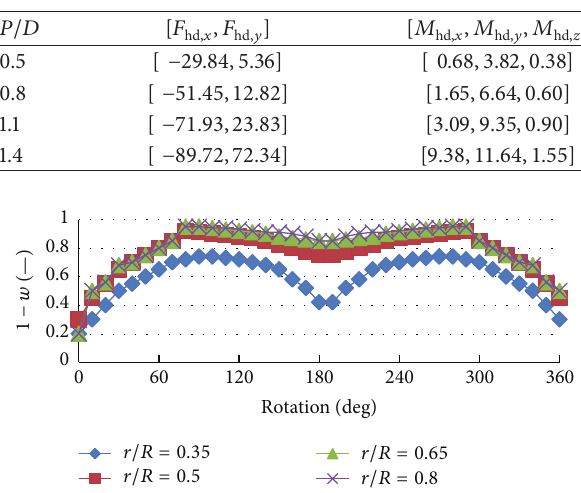
Figure 11: Nominal wake-field around the investigated propeller.